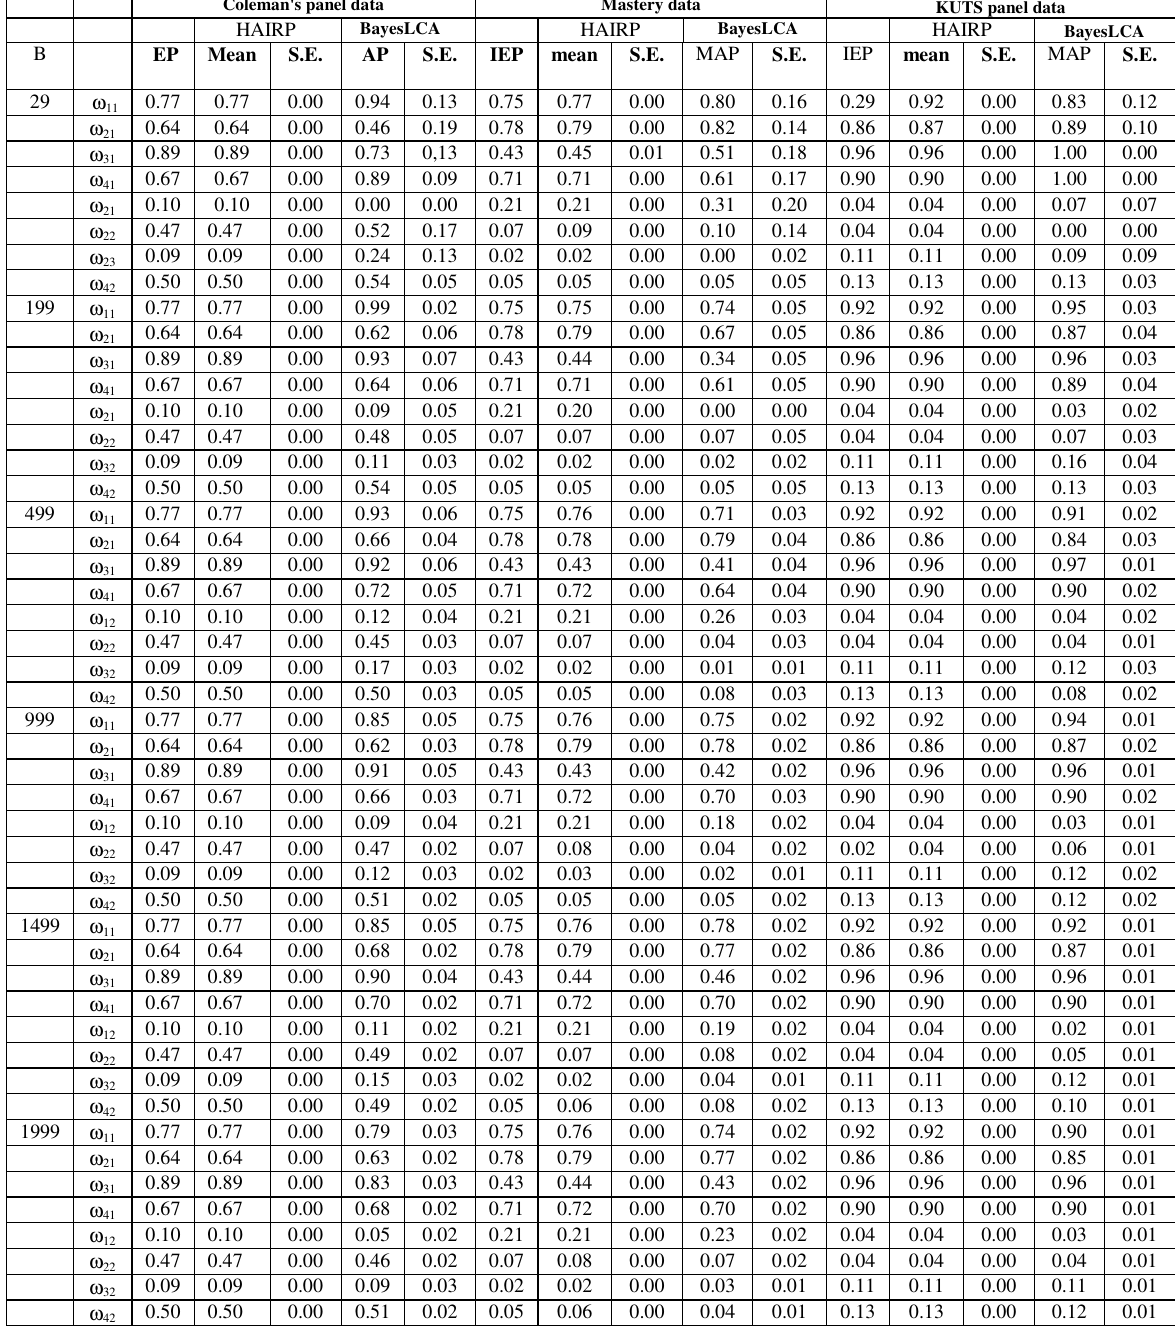
TABLE 5: A COMPARISON OF THE RESULTS OBTAINED THROUGH HAIRP WITH BAYESLCA FOR COLEMAN’S PANEL, MASTERY AND KUTS PANEL DATA (MEAN EST IMATES (MEAN), STANDARD ERRORS (S.E.) THROUGH HAIRP) AND (MAXIMUM A POSTERIORI (MAP) AND STANDARD ERROR (S.E.) THROUGH